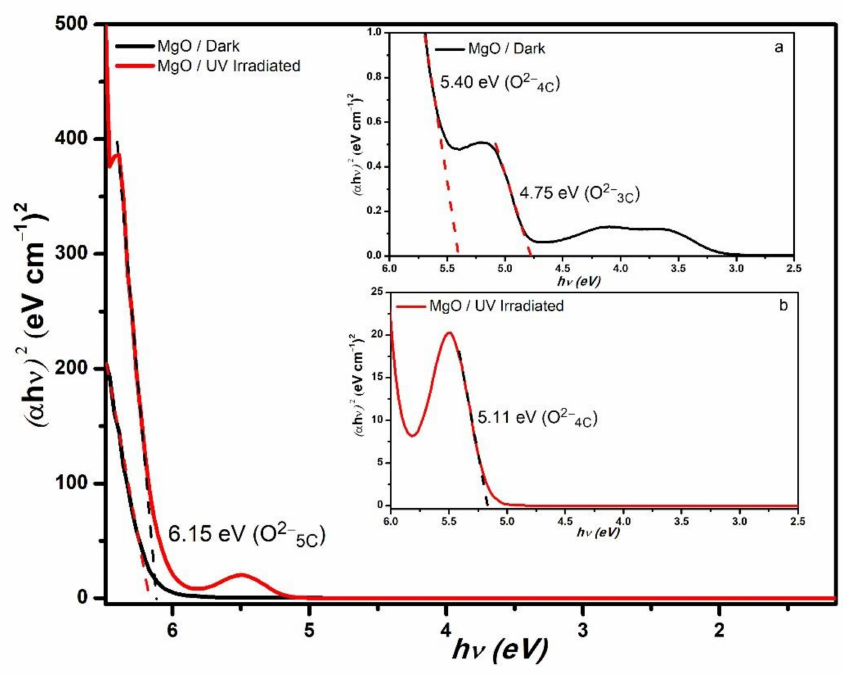
Figure 5. Tauc plots for the MgO nanoparticles stored in the dark and those irradiated by the UV lamp for 4 h. Insets ( a , b ) show a zoom to the curves in order to appreciate the low absorbance region.